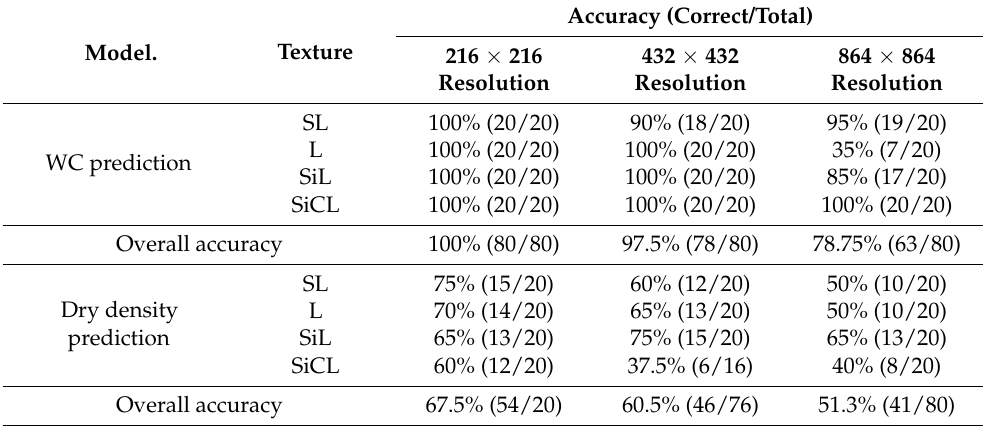
Table 1. Classification results by the convolutional neural network model.